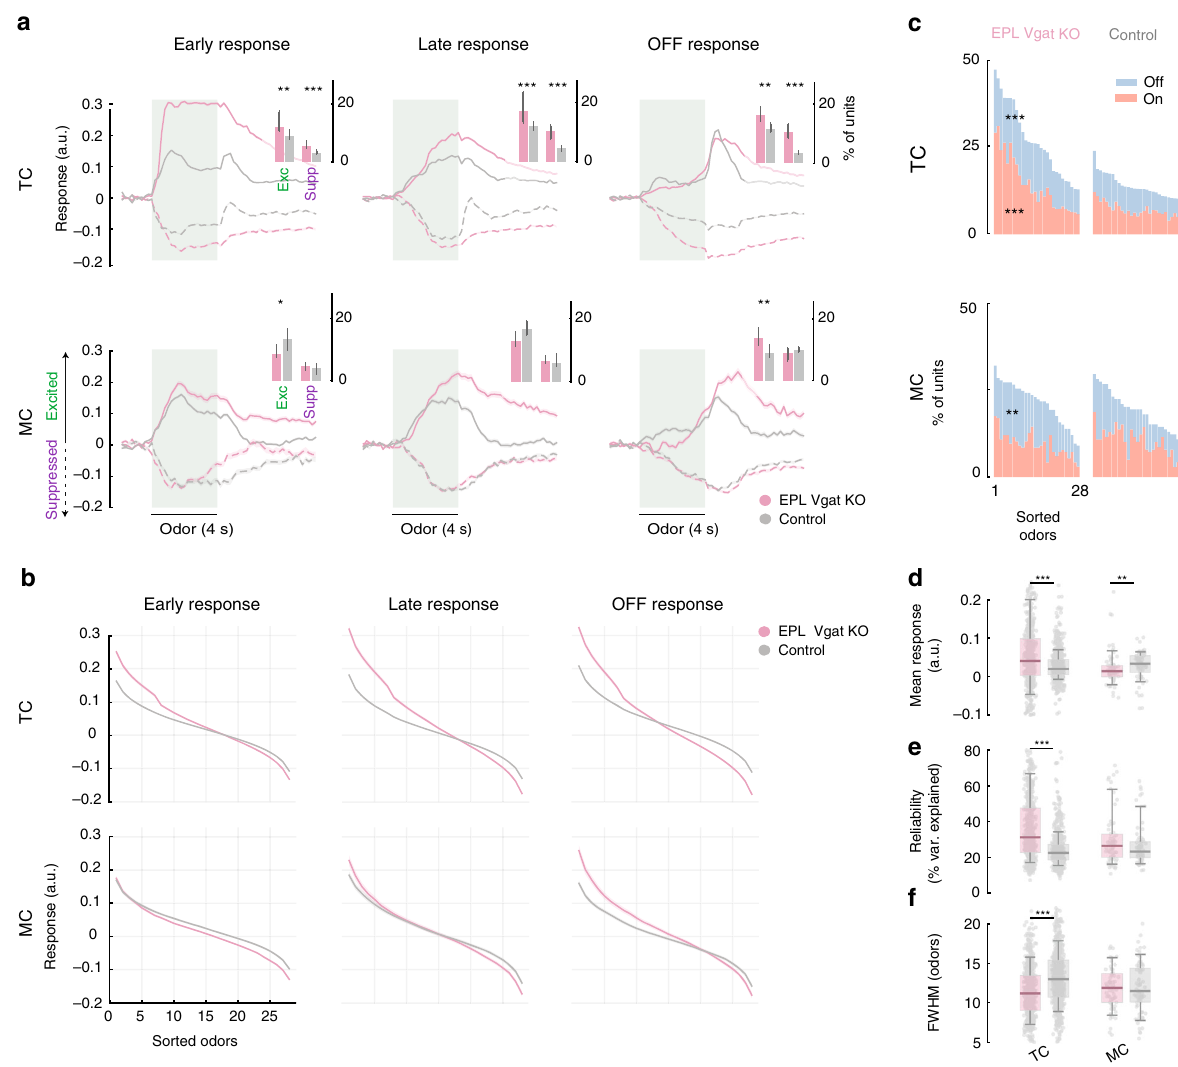
Fig. 5 TC and MC odor responses are differentially affected. a Average calcium responses to odors across all signi fi cant cell-odor pairs separated by period of a signi fi cant response (uniform line) and suppressed (dotted line) units between EPL Vgat KO and control animals. TC (top), and MC (bottom). Insert bar plot shows the percentage of responses signi fi cantly altered. Responses divided by response latency into Early ( fi rst 2 s of odor), Late (last 2s of odor), and Off (2s after odor is turned off). The number of unit-odor pairs: excited KO group: Early: TC = 5331, MC = 480 Late: TC = 2688, MC = 395, OFF: TC = 1910, MC = 246 suppressed KO group: Early: TC = 2396, MC = 290 Late: TC = 2711, MC = 361, OFF: TC = 4011, MC = 502 excited Control group: Early: TC = 6679, MC = 566 Late: TC = 4650, MC = 305, OFF: TC = 4879, MC = 181 suppressed Control group: Early: TC = 2229, MC = 153 Late: TC = 3057, MC = 295, OFF: TC = 2557, MC = 478. b Average tuning functions across all cells with signi fi cant responses. Shaded area represents SEM computed over cells. c Histograms represent the total fraction of cells with signi fi cant odor responses. Red is signi fi cant for on response (Early), blue is signi fi cant for off response. d Average response strength across all odors. e Reliability of odor response (see “ Methods ” section). f Tuning width as the FWHM of the fi tted exponential function for each cell as in ( d ). For d – f Box plots are computed across all cells — bounds of the box span from 25 to 75% percentile, center line represents median, and whiskers visualize 10 and 90% of the data points. For visibility, the extreme outliers are not presented. The number of cells for EPL Vgat KO animals: TC = 646, MC = 66, for control animals: TC = 808, MC = 72, *** p < 0.001, ** p < 0.01, * p < 0.05, Wilcoxon